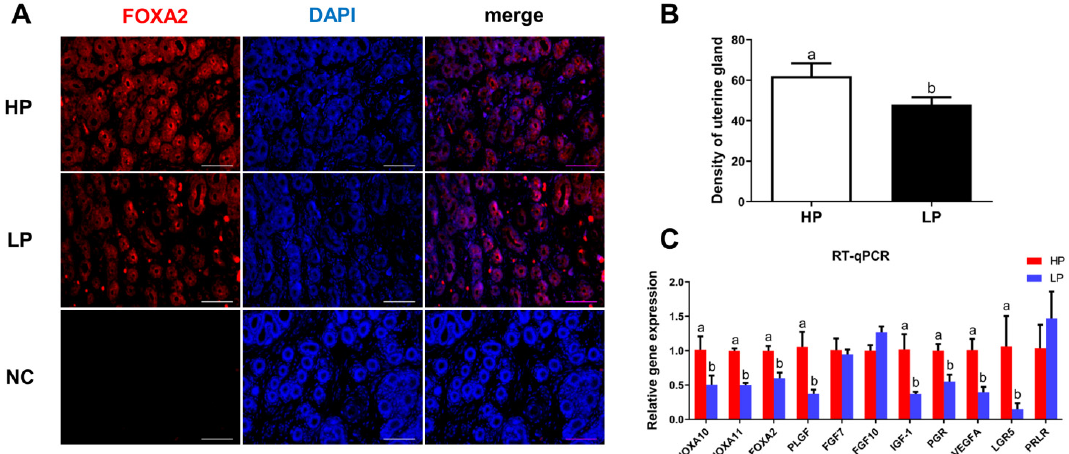
Figure 1. Analysis of UGs in Hu sheep with different fecundity. ( A ) Immunolocalization of UGs using FOXA2 antibody. UGs, uterine glands. HP, high prolificacy rate Hu sheep; LP, low prolificacy rate Hu sheep; NC, negative control was not incubated with primary antibody; DAPI, 4, 6-diamidino-2-phenylindole, blue nuclear stain. ( B ) Analysis the density of the UGs. ( C ) Relative expression of genes involved in UG development. HOXA10/11, Homeobox A10/11; FOXA2; Forkhead box A2; PLGF, placental growth factor; FGF7/10, Fibroblast growth factor 7/10; IGF-1, insulin like growth factor 1; PGR, progesterone receptor; VEGFA, vascular endothelial growth factor A; LGR5, leucine rich repeat containing G protein-coupled receptor 5; PRLR, prolactin receptor. The values represent means ± SDs. Means with different letters indicate significant differences ( p < 0.05). Bar = 50 μ m.